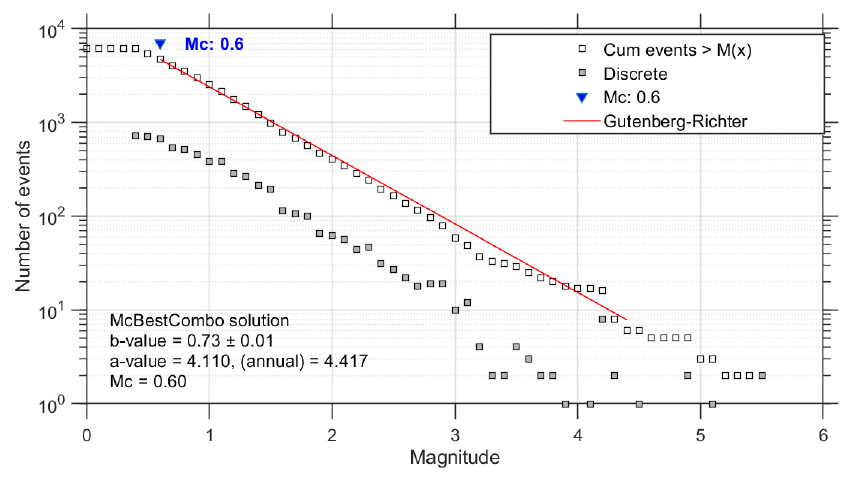
Figure 2. Gutenberg–Richter distributions of the magnitude of the earthquakes within the Dobrovolsky radius.